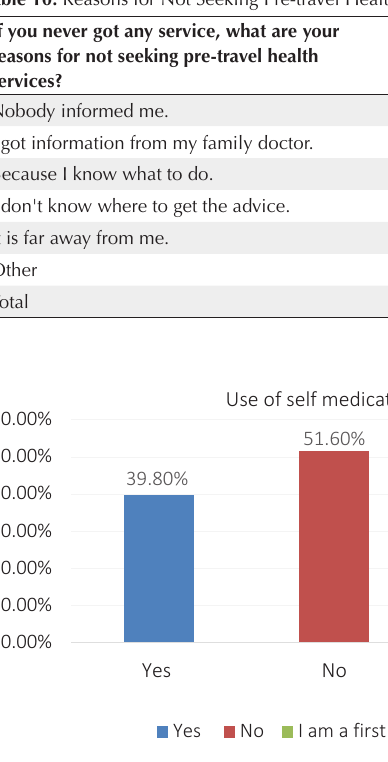
Figure 8. Use of Self-medication (n=384)